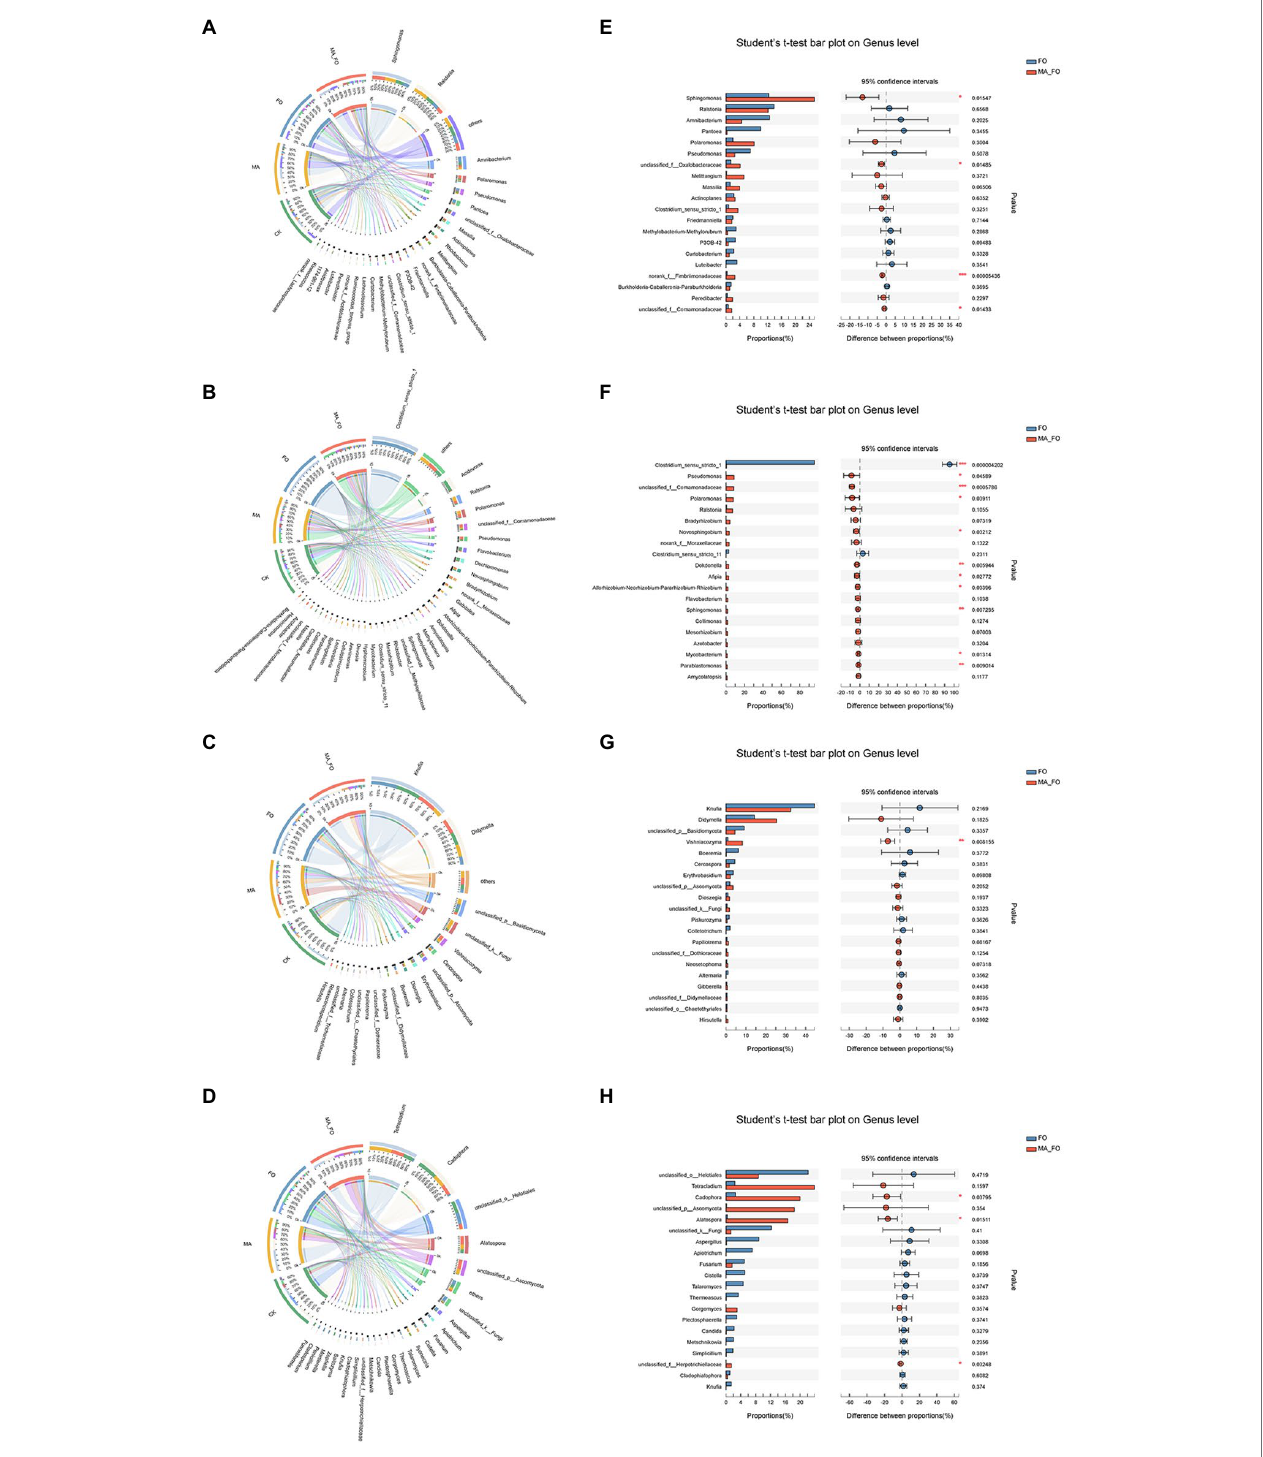
FIGURE 5 | Analysis of microbial composition and differences in ginseng. Effects of different inoculation treatments on internal bacteria ( (A) aboveground of ginseng; (B) root of ginseng) and fungi ( (C) aboveground of ginseng; (D) root of ginseng) of ginseng. The left semicircle represents the different inoculation treatments. The right semicircle represents the dominant genera and proportions of each genus in different samples. Student’s t -test was used to test the significance of differences between FO and MA_FO at the genus level ( (E) aboveground bacteria of ginseng; (F) root bacteria of ginseng; (G) aboveground fungi of ginseng; (H) root fungi of ginseng). The y -axis represents the species names at the genus level, the x -axis represents the average relative abundance in different groups of species, and the columns with different colors represents different groups. The far right is the value of p , * p < 0.05; ** p < 0.01; *** p <